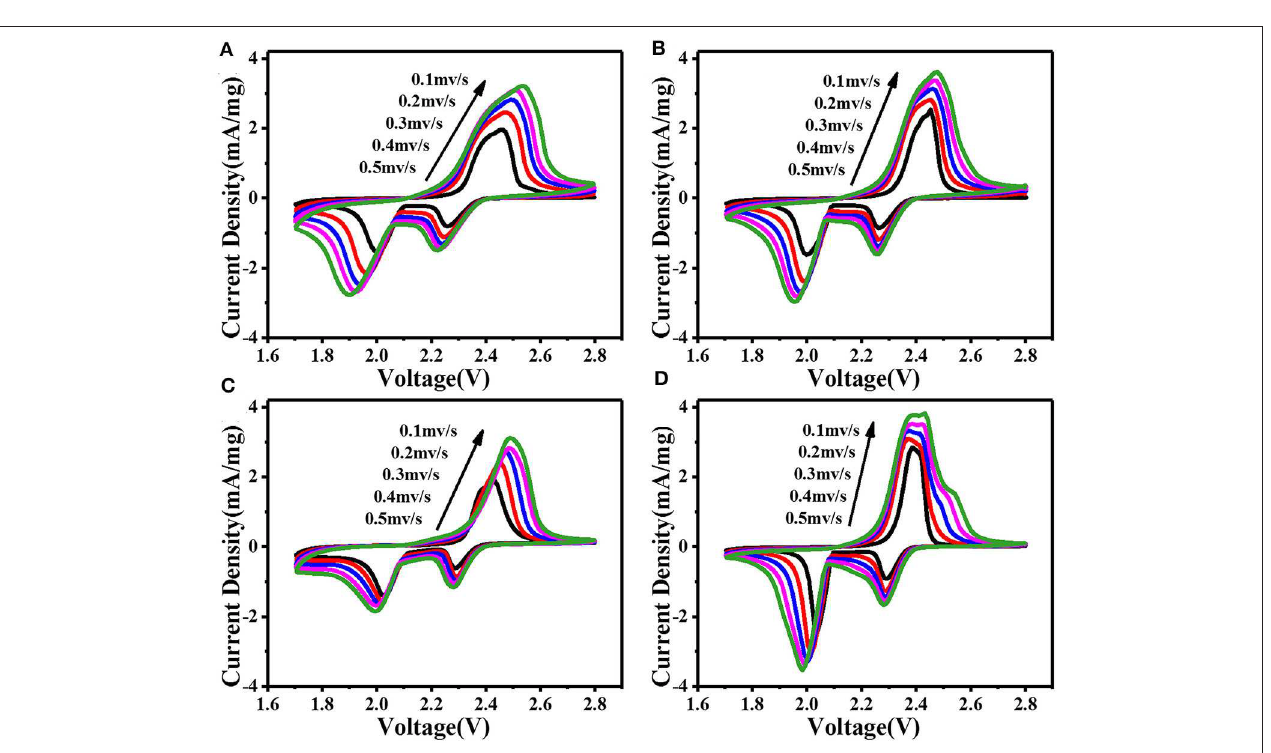
Frontiers in Chemistry |